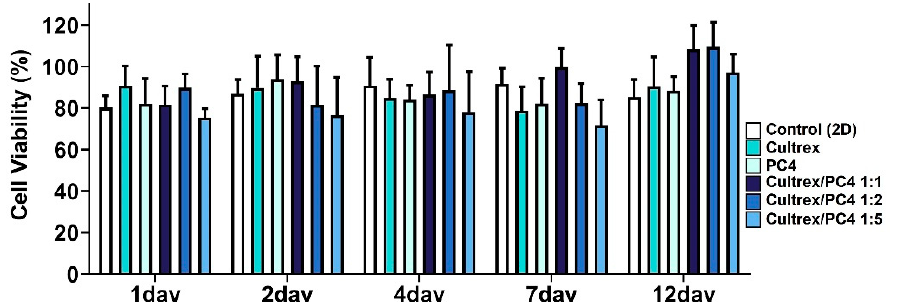
Figure 3. Cell viability in HepG2 cells cultured in different hydrogels. Cells were plated on 96-well plates (1 × 104 cells/well) for various time points with different culture conditions. After incubation for 1 to 12 days, cell viability was measured by MTT assay. No statistical differences were present at all time points in the following groups: 2D, Cultrex, PC4, PC4/Cultrex at 1:1 ratio, PC4/Cultrex at 1:2 ratio, and PC4/Cultrex at 1:5 ratio. Data are expressed as mean ± SD from three independent experiments.